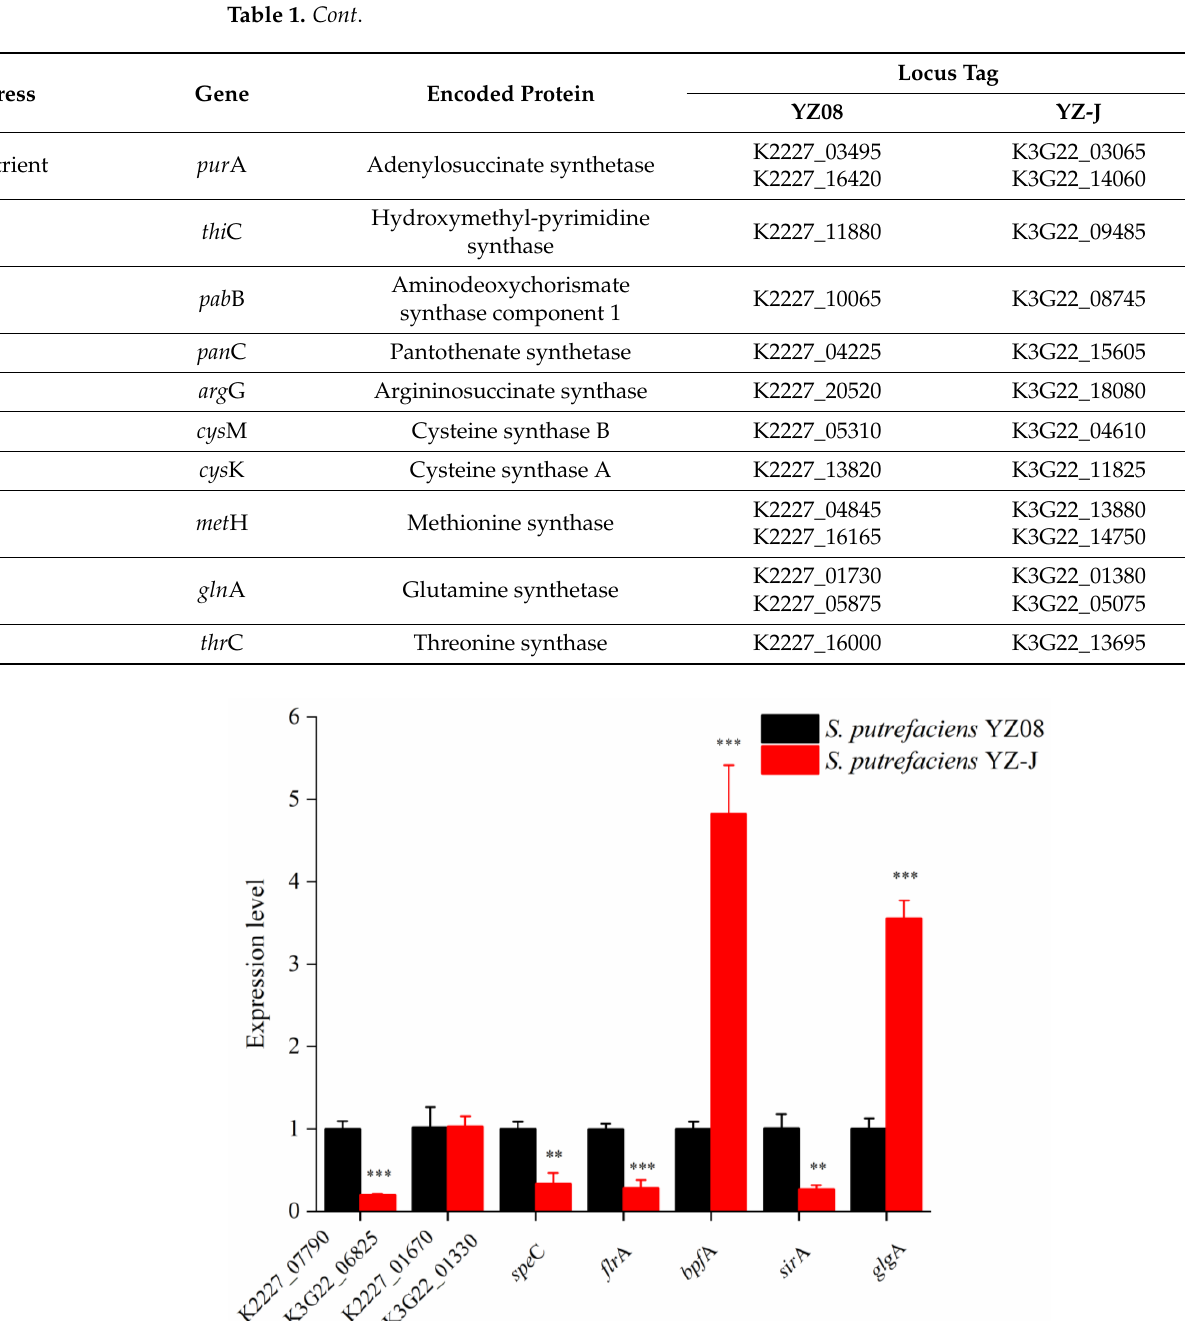
Figure 5. Comparison of the expression levels of biofilm formation-related and spoilage-related genes associated with salt stress between Shewanella putrefaciens strains YZ-J and YZ08. Gene expression levels in S. putrefaciens YZ-J are expressed as values relative to the control group ( S. putrefaciens YZ08). ** p < 0.01, *** p < 0.001.